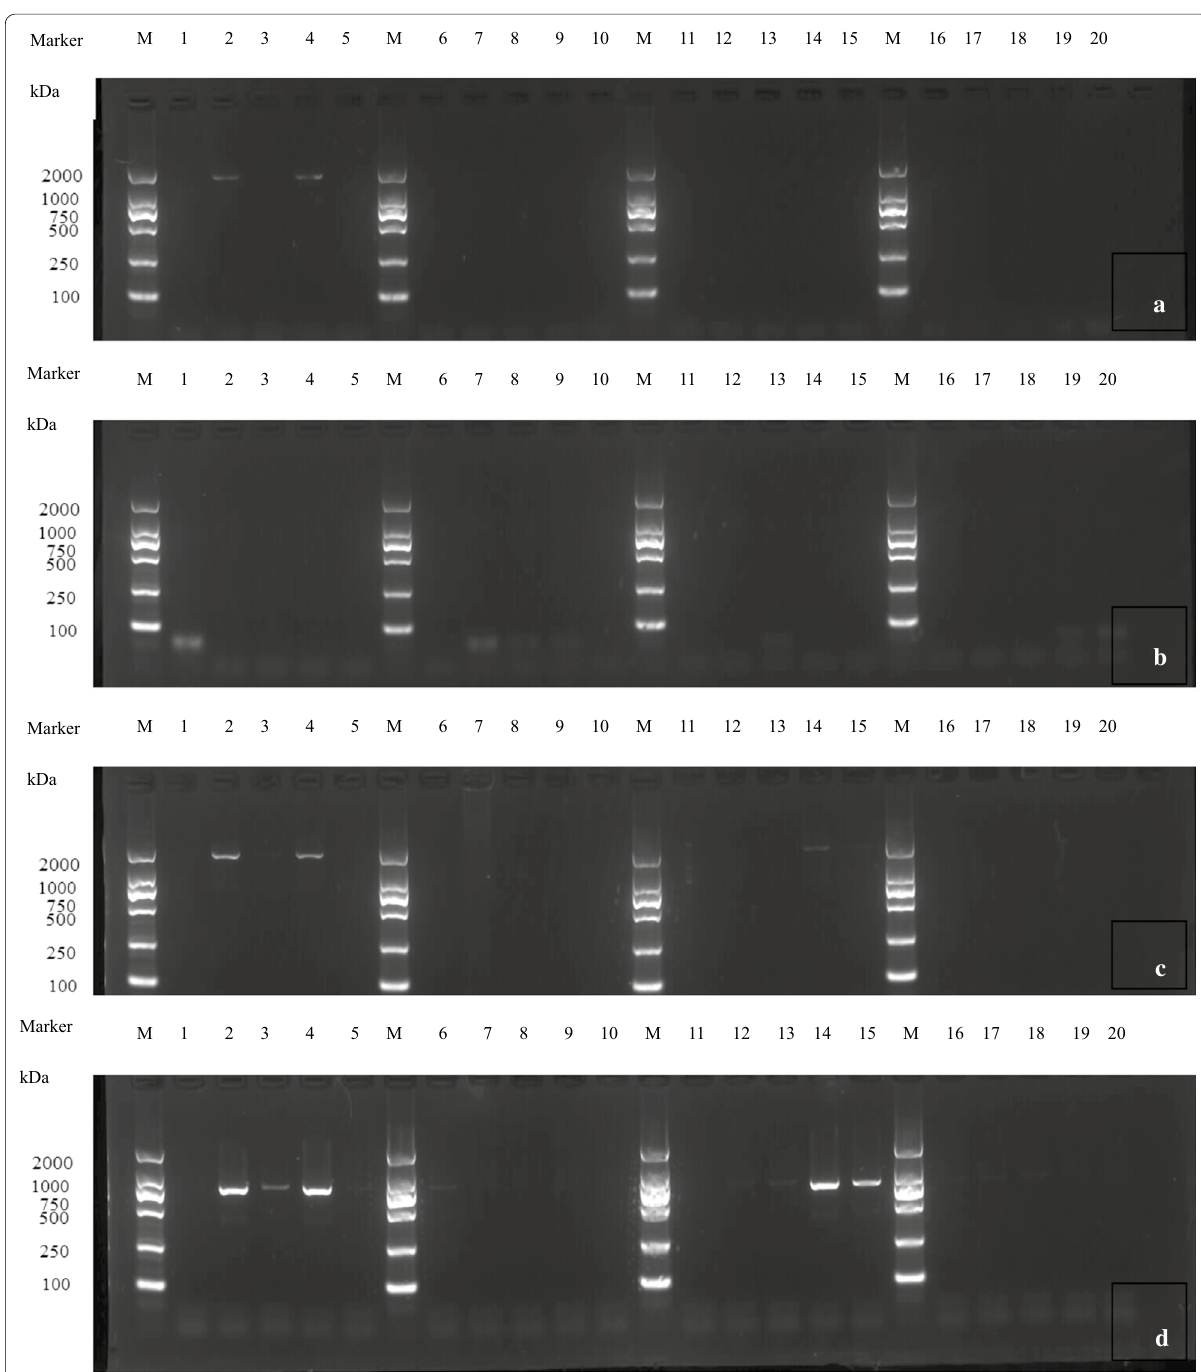
Fig. 2 Effect of active compounds on expression of genes encoding PVY functional proteins: HC - pro , P3 , NIb and NIa . a gene HC - Pro; b gene P3; c gene NIb; d gene NIa. M: Marker lane; Series of Lanes 1–5: compound 5 ; 6–10: compound 1; 11–15: compound 9 ; 16–20: compound 4. Each series of 5 lanes between markers represents the concentrations used: 500, 250, 125, 63, and 31 μg/mL, from left to